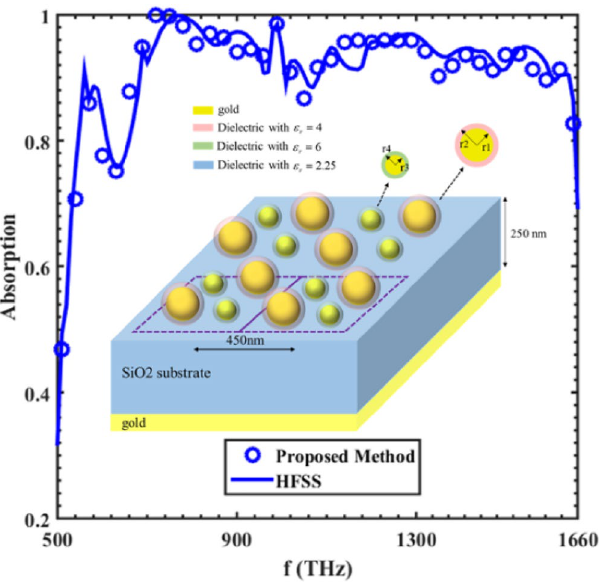
Figure 9. Absorption spectra for the proposed core–shell structure. See inset for